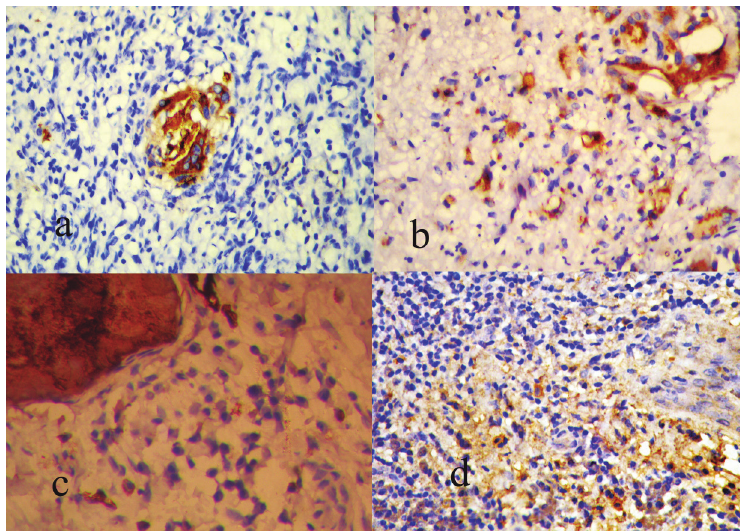
Figure 3- a) Pyogenic granuloma showing osteopontin (OPN) expression in stromal cells and extracellular matrix (40x); b) Higher magnification showing OPN expression in extracellular matrix of pyogenic granuloma; c) Inflammatory fibroepithelial hyperplasia (IFH) showing OPN expression in calcified structures, inflammatory and stromal cells (40x); d) OPN expression in inflammatory cells and in extracellular matrix of pyogenic granuloma